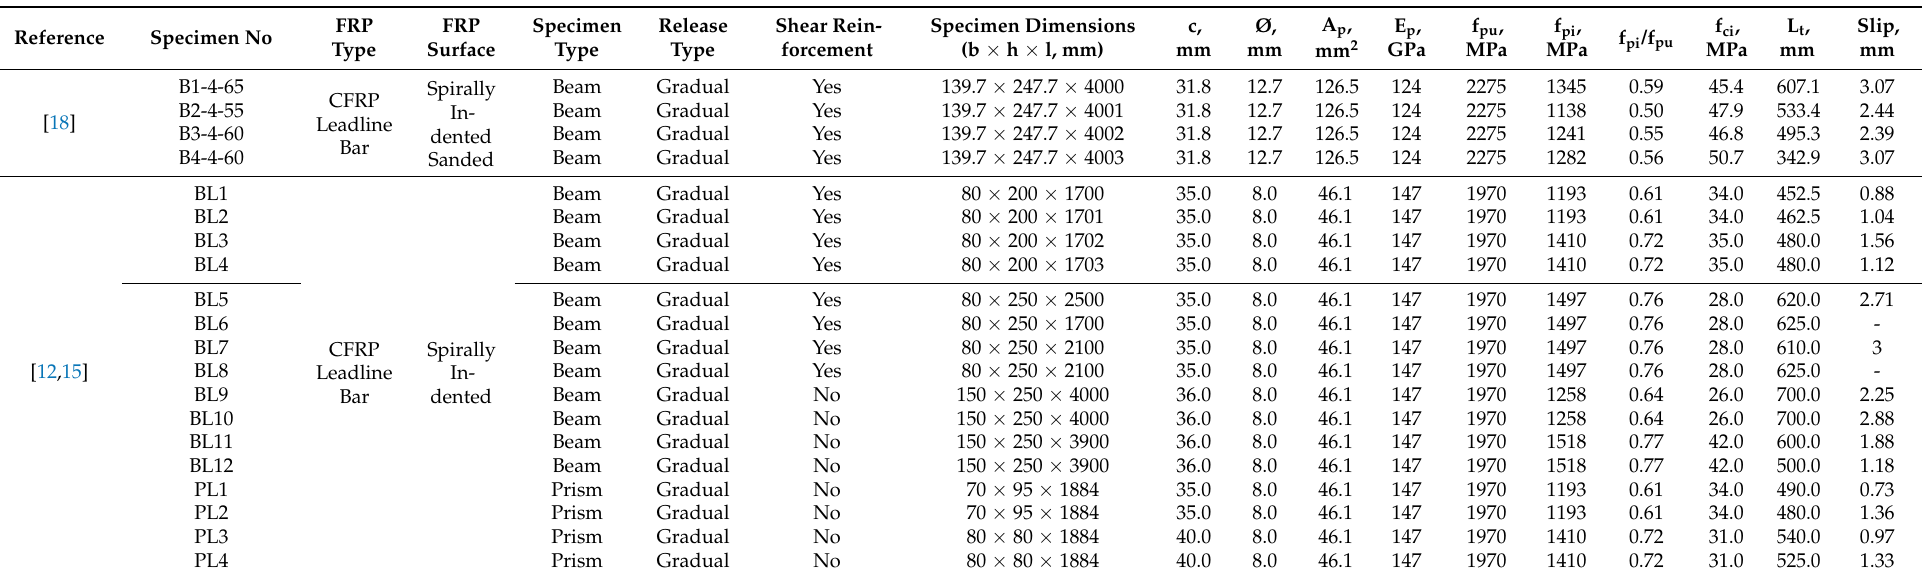
Table A2. Experimental parameters of specimens with pretensioned CFRP